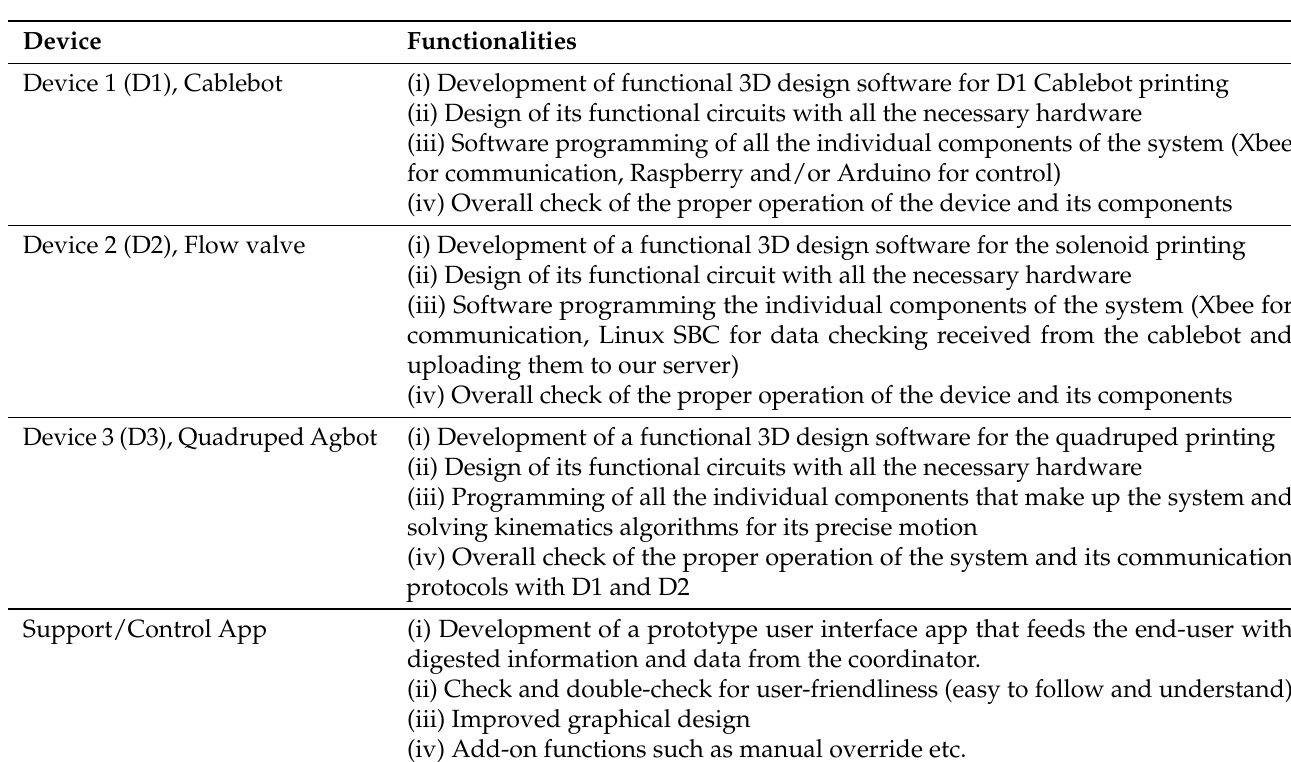
Figure 3. The cablebot. Table 2. Device